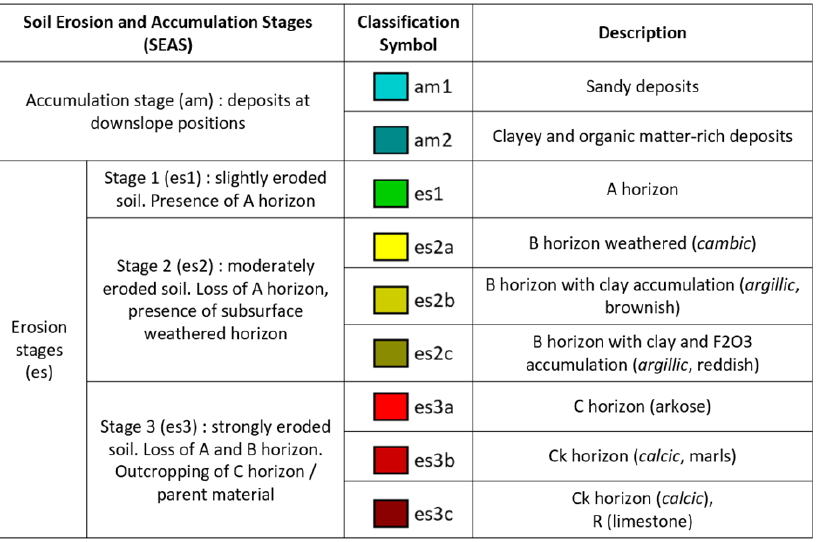
Figure 4. ( A ) Mapping of SEAS modified based on Schmid et al. (2016) [19] and highlight of ( B ) northern and ( C ) southern crop field sites of interest. 2.2. Airborne Data Acquisition and Processing